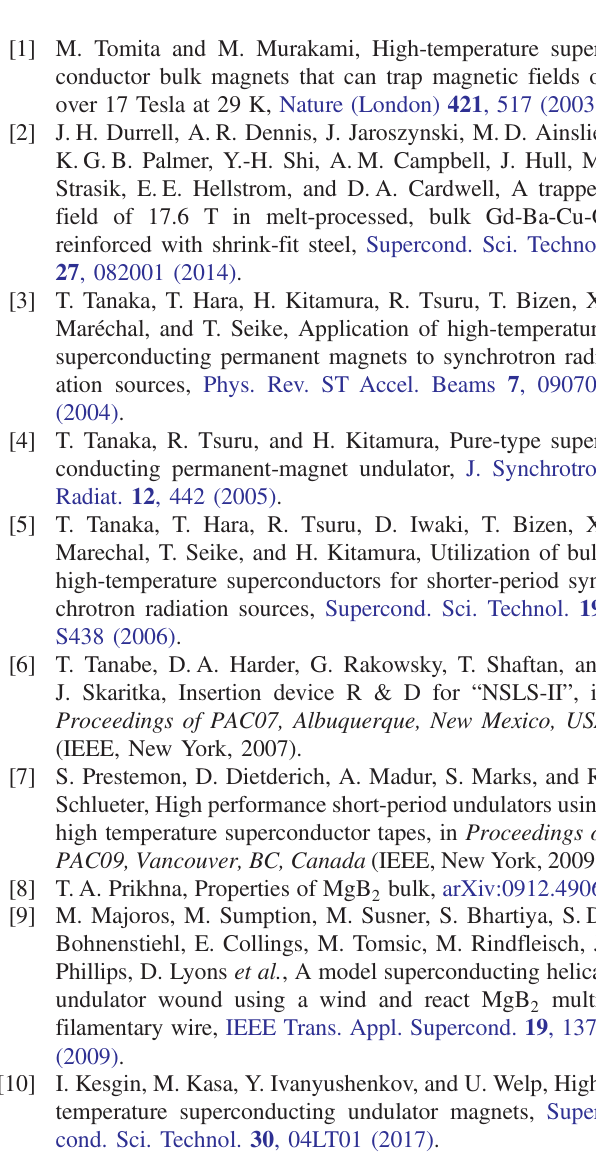
FIG. 12. Comparison of the results of the inverse analysis with the ANSYS backward computation method for 20 K and B